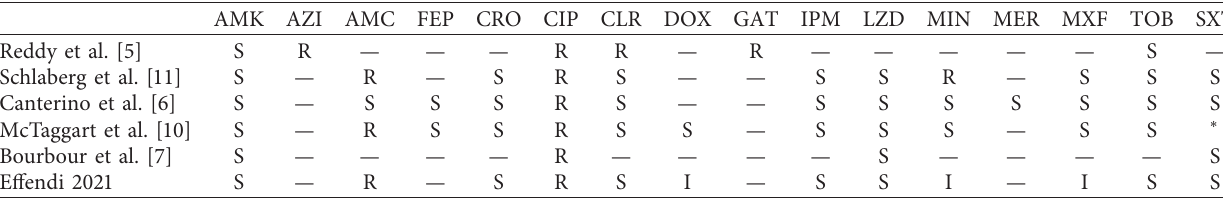
Table 1: Susceptibility profile of Nocardia thailandica based on the existing published